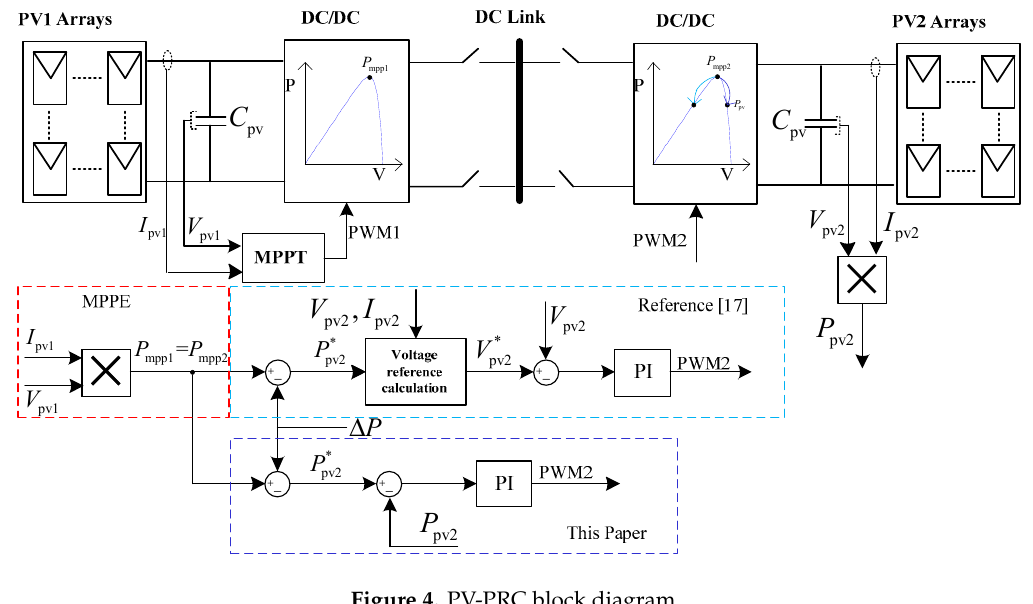
Figure 4. PV-PRC block diagram.